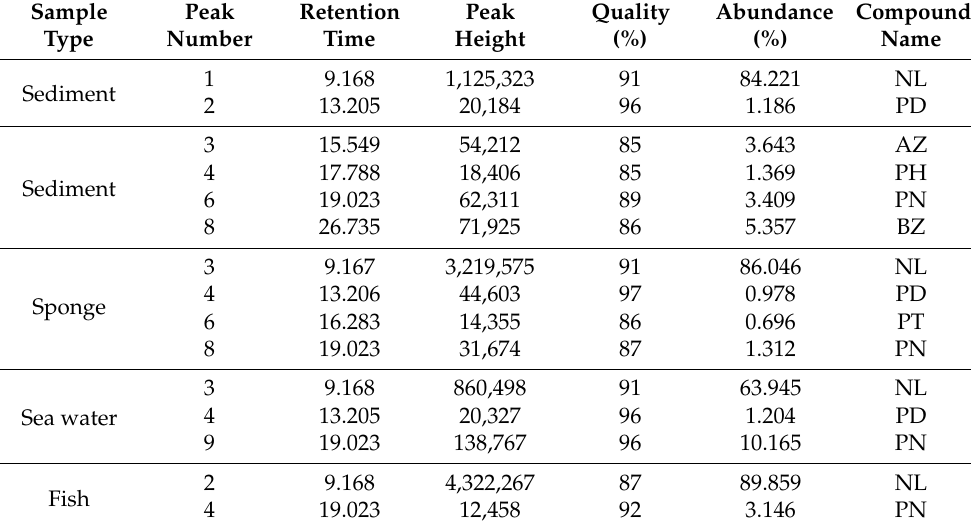
Table 5. Types and abundance of compound hydrocarbon and PAH in samples at ST 2 station based on GC/MS